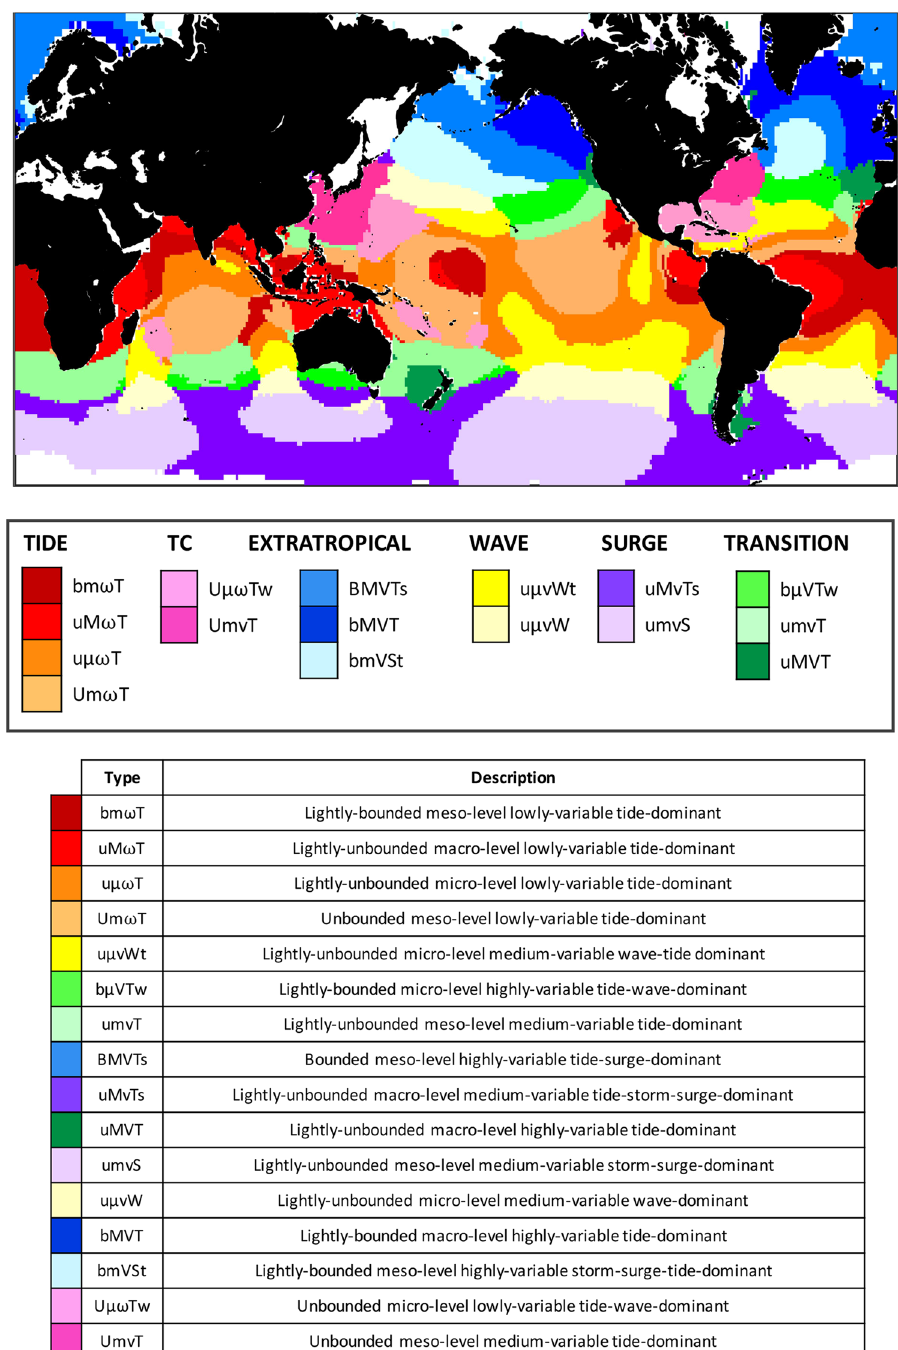
Figure 3. Global coastal flood hazard climates. (Upper panel) Global coastal flood hazard climates; (Lower panel) definition of each climate type. (Table) Type and description of each climate. This map was created with Matlab 2014b